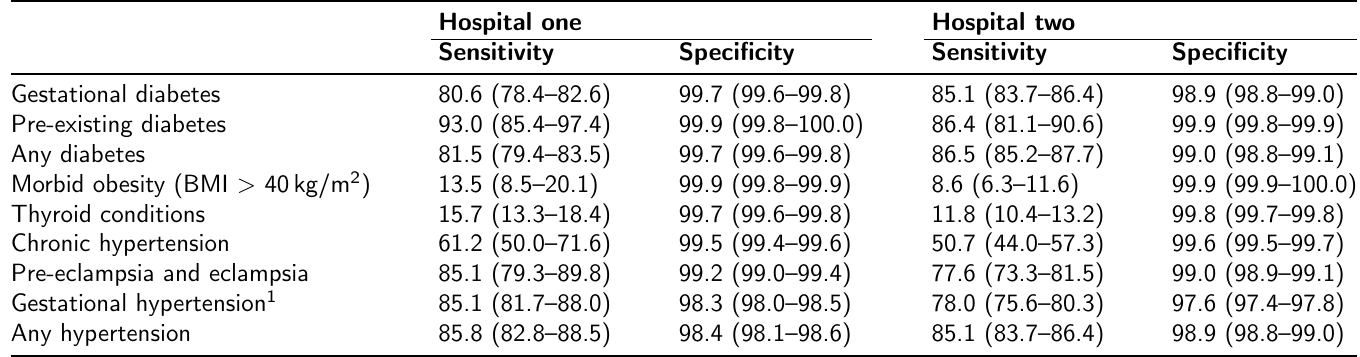
Supplementary Table 2: Sensitivity and specificity of reporting in coded hospital data compared to ObstetriX data as the reference standard, from two tertiary hospitals in New South Wales, 2011–2015, by